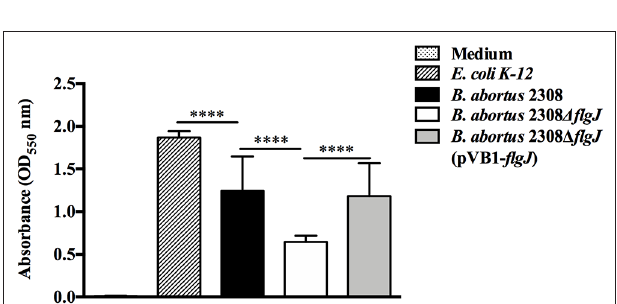
FIGURE 3 | Screening for biomass production. Quantitative measurement by absorbance to 550nm of adhered biomass production in 96-well polystyrene plates, of B. abortus 2,308, B. abortus 2308 1 flgJ , and complemented 2308 1 flgJ (pBV1- flgJ ) in addition to E. coli K-12 as a positive control of biomass production and culture medium as a negative control. Results are expressed as means ± standard deviation. Values of **** P < 0.001 are considered highly